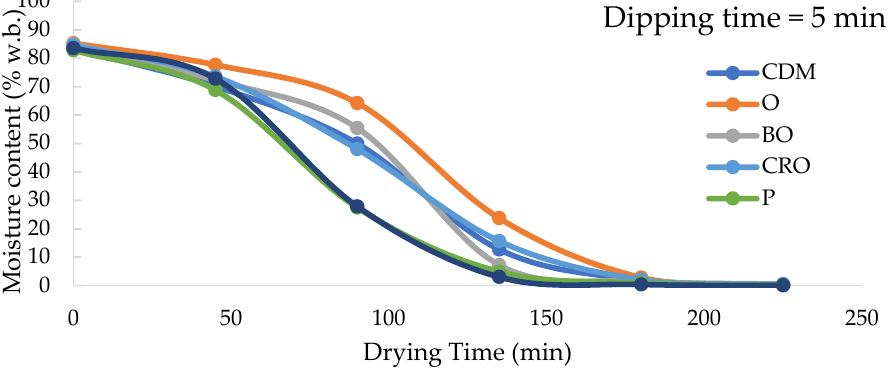
Figure 4. Effect of 3 min dipping time on drying time of different pre-treatments (tangerine ( Citrus deliciosa Mediterranean) (CDM); orange (O); bitter orange (BO); tangerine ( Citrus reticulate Owari ) (CRO); pomegranate (P); non-pre-treatment (NP)).